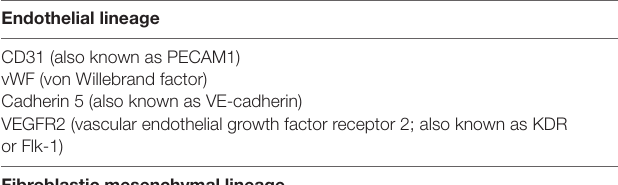
TABLE 1 | Lineage markers commonly used in studies of endothelial-mesenchymal transitions and vascular calcification. Endothelial